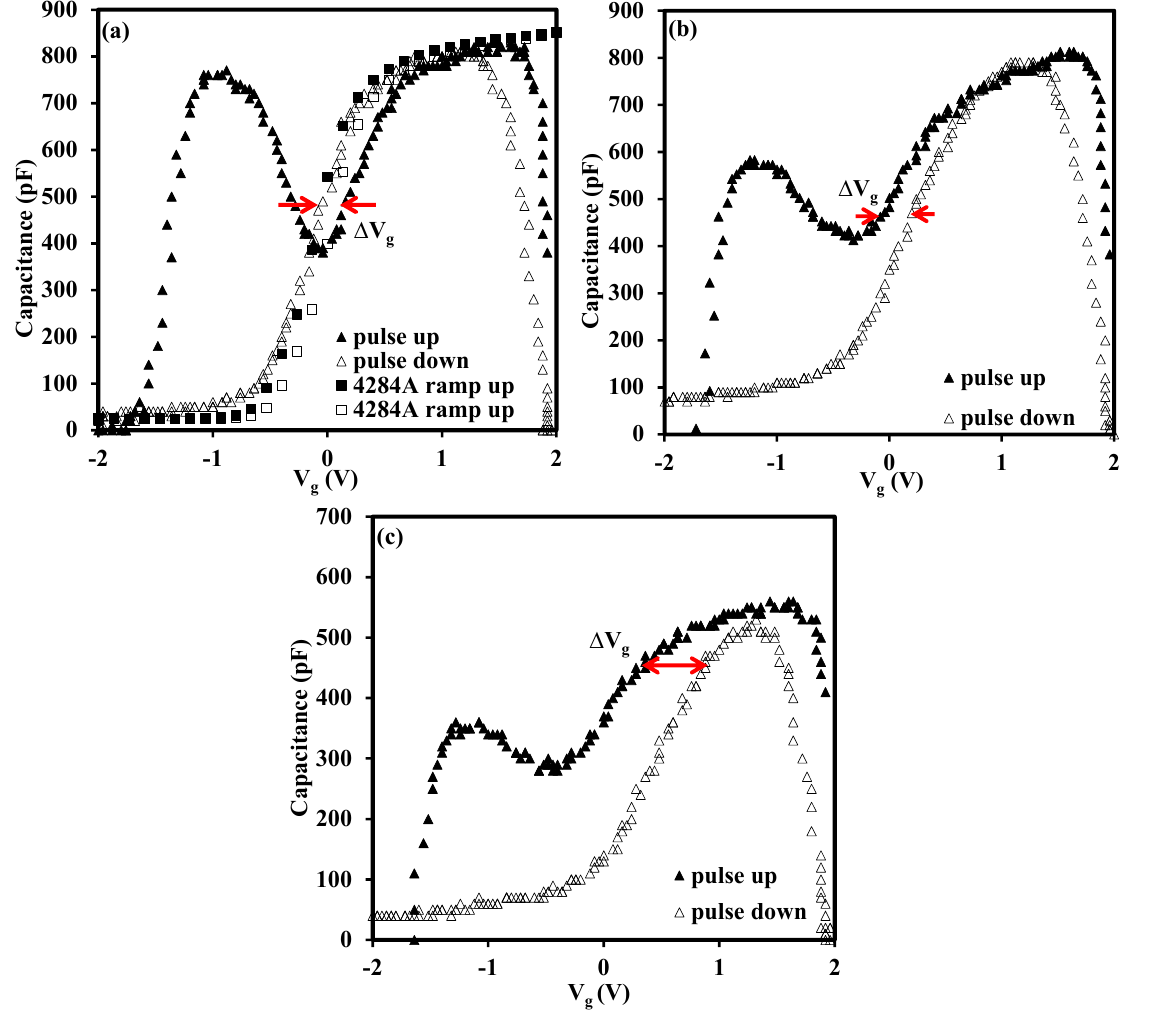
Figure 6. The influence of RTA on trap density (extracted from V g indicated in each